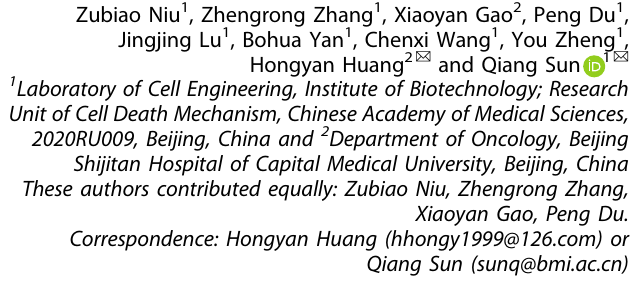
Fig. 1 N501Y S glycoprotein binds to mouse ACE2 to mediate host entry and infection. a Schematic illustration of mutations in the spike protein of three SARS-CoV-2 variants: B.1.1.7, B.1.351 and P.1. Arrow indicates the N501Y mutation that was shared by the three variants in the receptor-binding domain (RBD) of S glycoprotein. b , c Representative images ( b ) and quanti fi cation ( c ) of syncytia formation upon expression of the indicated S glycoprotein in 293T cells expressing human ACE2 (hACE2) and mouse ACE2 (mACE2), respectively. Scale bars: 200 μ m. Data are the mean ± SD of results from 4-5 fi elds (20x objective lens). ns not signi fi cant; **** p < 0.0001. More than three replicates were performed. d Expression of two types of spike proteins in the absence and presence of hACE2 and mACE2 in 293T cells 48 h post transfection by Western blot. FL full length. α -tubulin serves as the loading control. e Expression of the luciferase reporter in 293T-hACE2 and 293T-mACE2 cells upon infection of viruses pseudotyped with N501 or Y501 S glycoproteins as indicated. Data are the mean±SD of triplicate measurements. ns: not signi fi cant; **** p < 0.0001. f Three-dimensional structure modeling of the N501 and Y501 S glycoproteins in complexed with hACE2 and mACE2, respectively. The most left image shows the S glycoprotein trimer-ACE2 complex. Zoomed images show the interfaces of different complexes as indicated. The N501, Y501, Y353, and H353 residues are displayed in the style of scaled ball and stick with potential interaction bonds shown in dashed lines. g , h The Fc-tagged N501 ( g ) and Y501 ( h ) RBDs of SARS-CoV-2 S glycoprotein bind to His-tagged hACE2